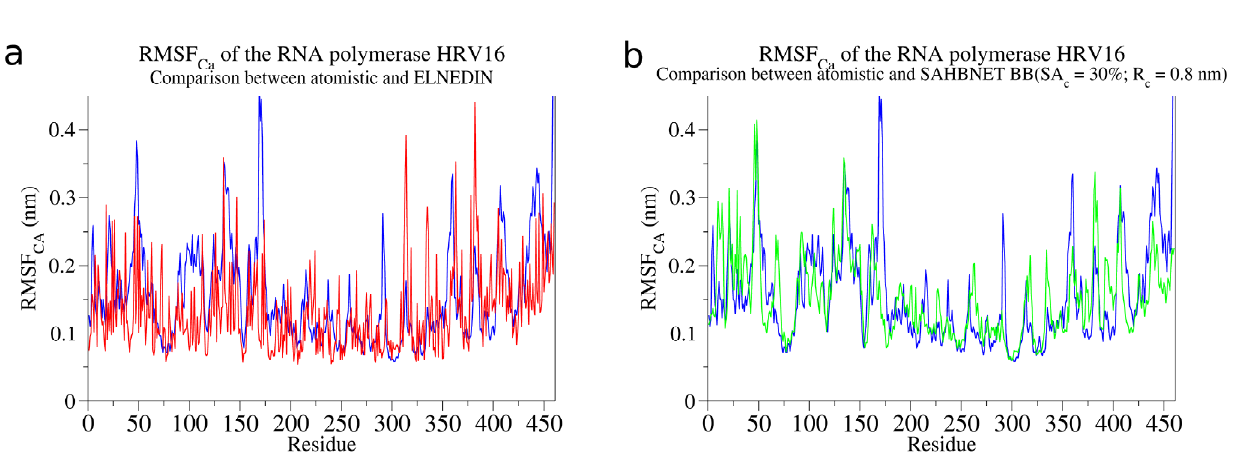
= 30%, R = 0.8 nm c c